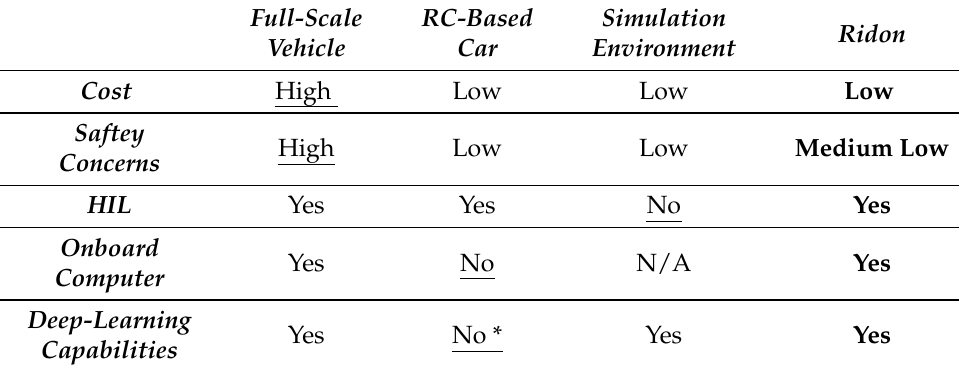
Table 5. Comparing different options for drive-by-wire system development. * it could be possible using a remote computer connected to the on-board